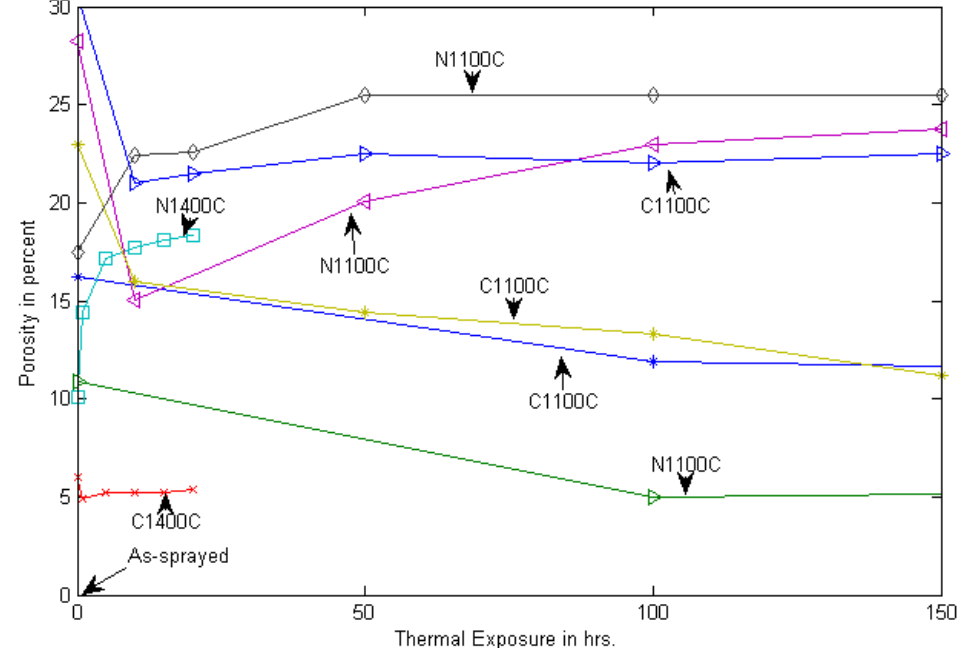
Figure 3. Sintering effects on porosity level in C tbc and N tbc . Data collected from published sources are plotted only up to 150 h of sintering to highlight the trend [12,17,69,87]. N and C stand for N tbc and C tbc . The sintering temperature in °C is shown for each line.